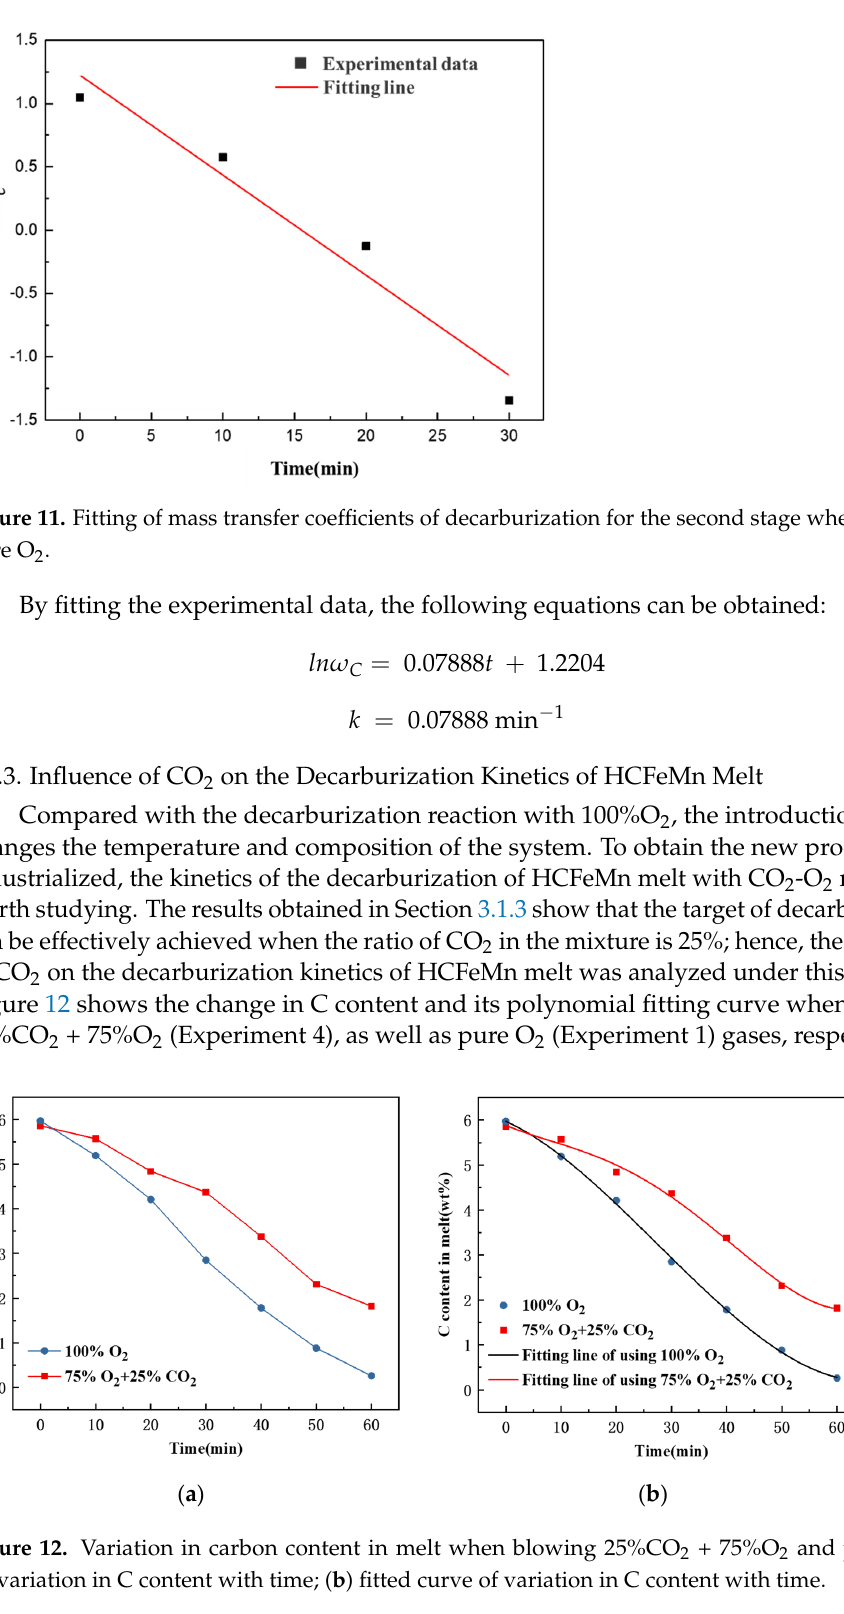
( b ) Figure 13. Variation in decarburization rate when blowing 25%CO 2 + 75%O 2 and 100%O 2 : ( a ) varia ‐ tion in decarburization rate with time; ( b ) variation in decarburization rate with C content in the melt. As can be seen from Figure 13a, the decarburization rate decreases at the beginning of the experiment when the CO 2 ‐ O 2 gas is applied. Then, it increases between 10 and 40 min, before decreasing rapidly after reaching its highest point. Meanwhile, the decarburi ‐ zation rate first increases and then decreases when pure oxygen is blown. According to Figure 13b, the decarburization rate when blowing 25%CO 2 + 75%O 2 is always lower than that when blowing pure O 2 at the same C content. There is little difference in carbon